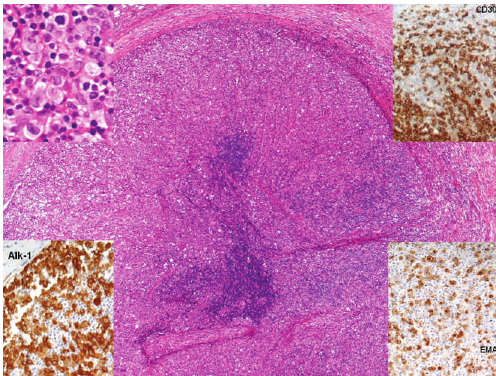
Figure 1: Duodenal biopsy following four year history of positive tTG-antibodies: Significant villous atrophy, hyperplastic crypts, dense mononuclear infiltrate in duodenal mucosa (Marsh 3a-b) (HE, × 40 original magnification). Pseudostratified enterocytes, increased number of intra-epithelial lymphocytes/IELs and loss of mucus cells (inset, HE, × 120 original magnification).